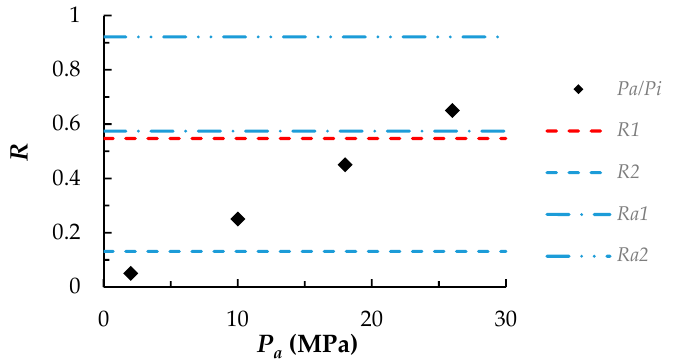
Figure 11. Distribution of pressure ratio under different ambient pressure at constant inlet pressure of 40 MPa.